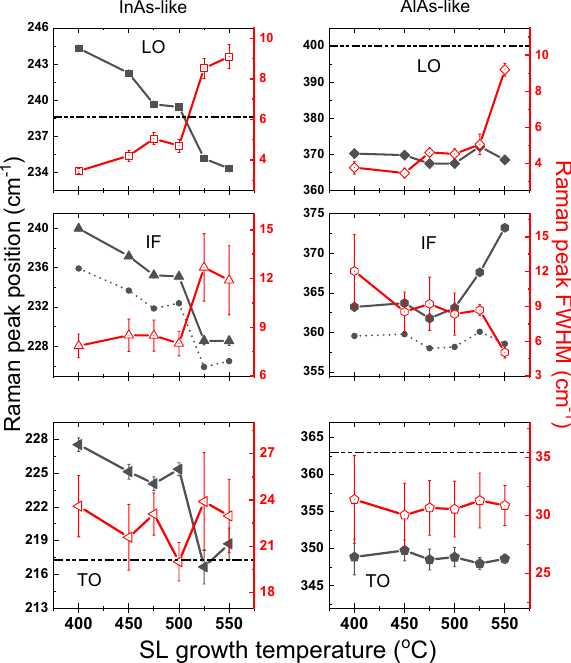
Figure 6. Peak positions and FWHMs of LO, IF, and TO phonon modes with error bars obtained from the fitting results concerning the growth temperature. The horizontal dashed lines indicate the phonon frequencies for bulk InAs and bulk AlAs. The scatters connected by dashed lines in IF modes indicate the mid-position of LO and TO modes.